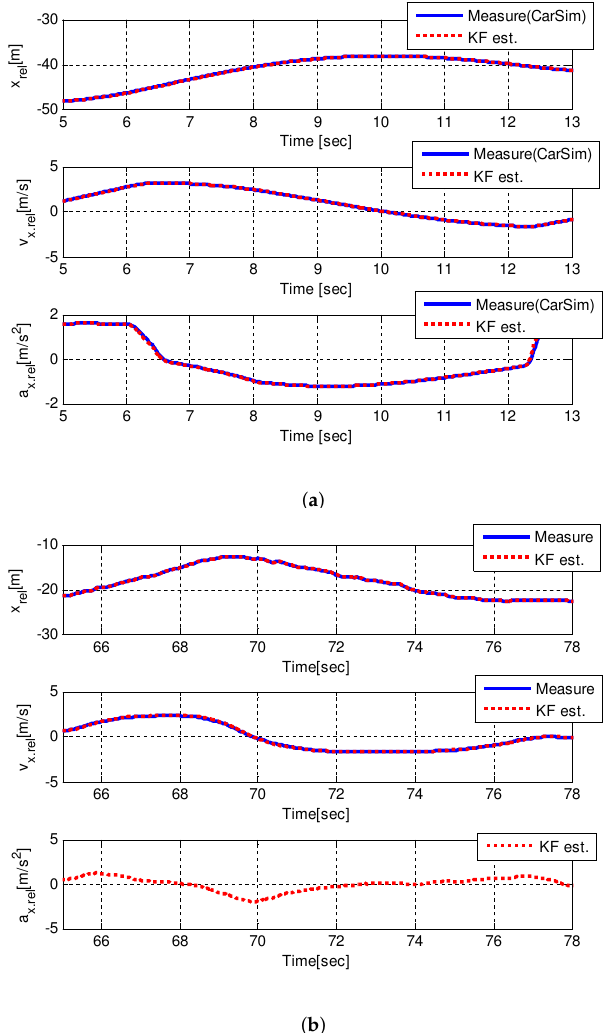
Figure 6. Estimation performances of the Kalman filter. ( a ) CarSim. ( b )